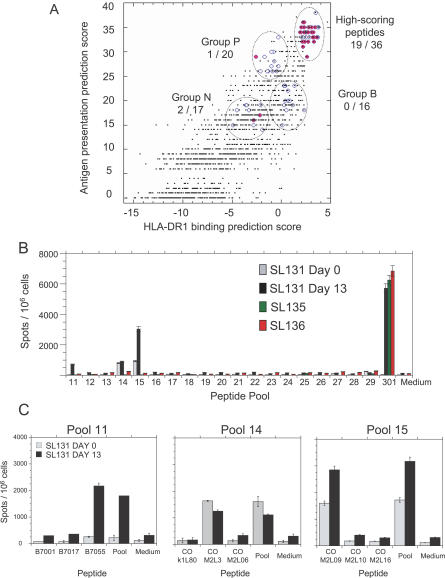
Validation of the Prediction Algorithm and Recognition of Vaccinia Peptides That Fell outside the Boundaries of the High Score Region for Binding and Presentation(A) HLA-DR1 predicted binding and predicted antigen presentation scores are shown for each 9-mer potential peptide epitope from the vaccinia genome, Open circles indicate peptides tested and closed red circles indicate peptides for which T cell responses were observed. This graph includes the 36 peptides presented in Figure 2 and the set of 53 peptides used to validate the prediction algorithm. Peptides are clustered according to their binding and presentation scores into groups H, P, B, and N. Only three peptides outside the H region are recognized by T cells.(B) IFN-γ ELISPOT responses of SL131, SL135, and SL136 TCLs to pools of peptides included in P, B, or N regions.(C) Deconvolution of the IFN-γ response of SL131 TCL day 0 (gray bars) and day 13 (solid bars) to positive pools.